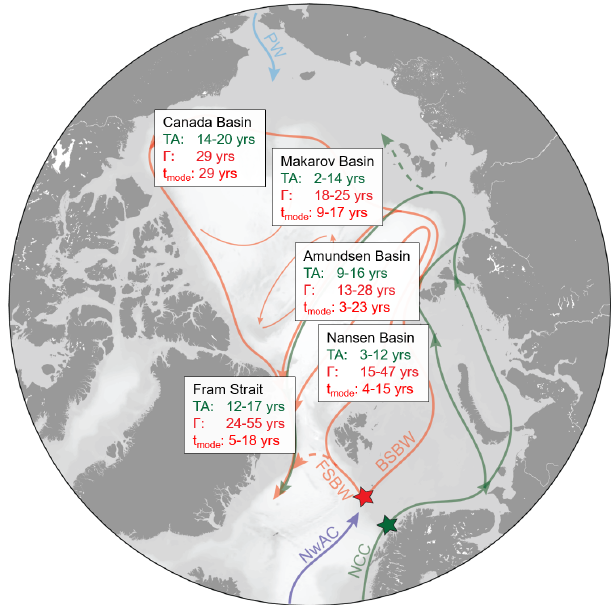
Figure 7. Summary of circulation times of Atlantic Water in the Arctic Ocean from this study: tracer ages (TAs) derived from the binary mixing model for the surface layer (green); mean ages ( (cid:48) ) and mode ages ( t mode ) derived from the TTD model for the mid- depth Atlantic layer